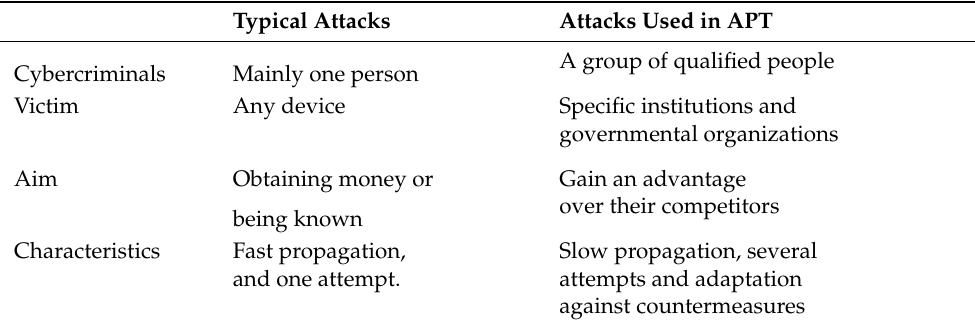
Table 1. Differences between usual malware and malware used in an APT attack. Typical Attacks Attacks Used in APT A group of qualified Cybercriminals Mainly one person